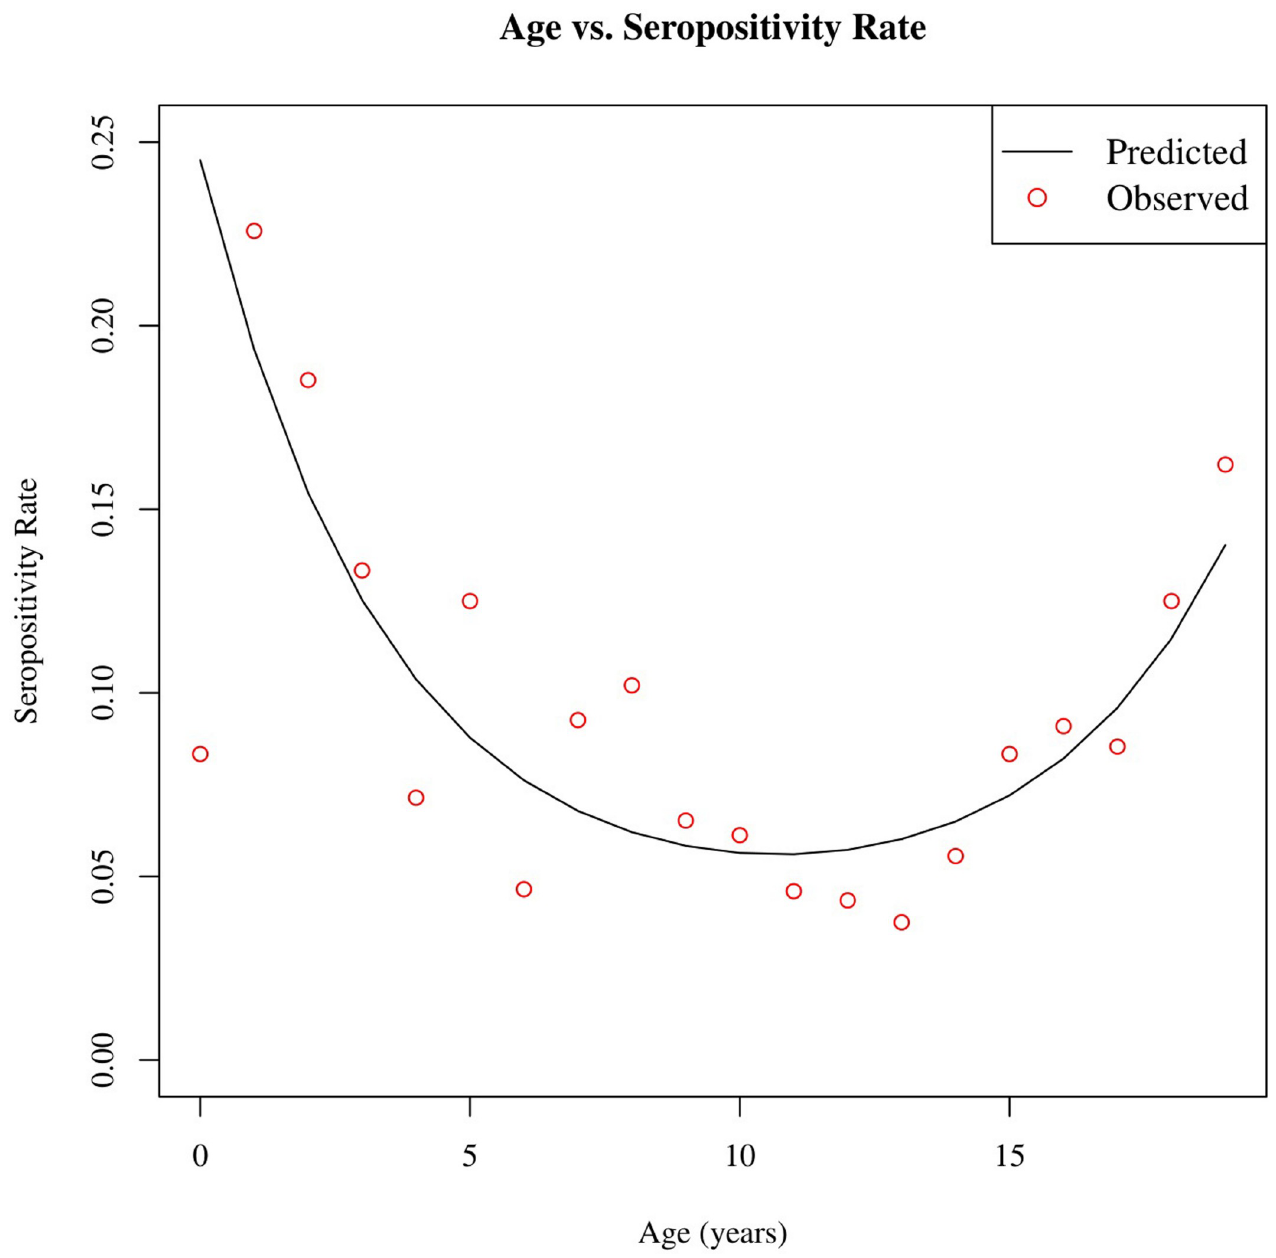
Fig 1. Pairwise plot of age vs. seropositivity rate (%). The red points represent the observed positivity rate in the cohort at each age, and the line is the predicted positivity rate produced by a quadratic regression model. The estimated seropositivity rate is higher for younger and older ages of children. https://doi.org/10.1371/journal.pone.0259823.g001 with symptoms within 2 weeks of testing, and those with symptoms more than 2 weeks before testing (p-value = 0.893, Kruskal-Wallis) (S3 Fig). Orthogonal testing was performed on 87/88 reactive samples (where enough serum remained) using the Siemens assay against the S1/RBD target. This demonstrated an 80.5% agreement with 70/87 samples reactive. Those with lower titer levels on the Ortho Clinical assay were more likely to test negative on the Siemens assay (p = 0.001, logistic regression) and